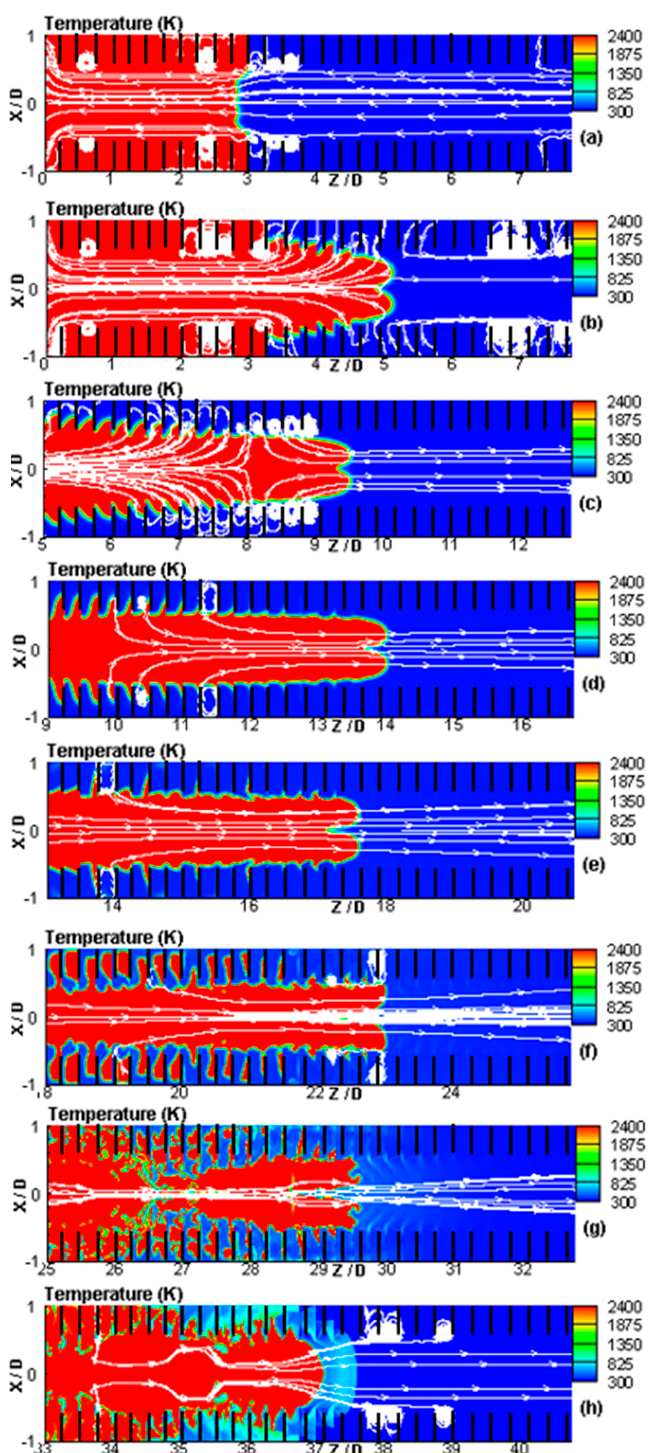
Figure 2. Consecutive color temperature snapshots for the evolution of a flame with the thermal expansion ratio Θ = 8 propagating in a channel with the blockage ratio α = 1/2: initial (concave) flame folding ( a ); transition to a convex flame ( b ); isolation of new pockets between the obstacles ( c ); fast flame acceleration ( d , e ); jet-flow formation along the channel centerline ( f ); development of a highly-corrugated flame structure ( g ); and disappearance of small-scale wrinkles ( h ).